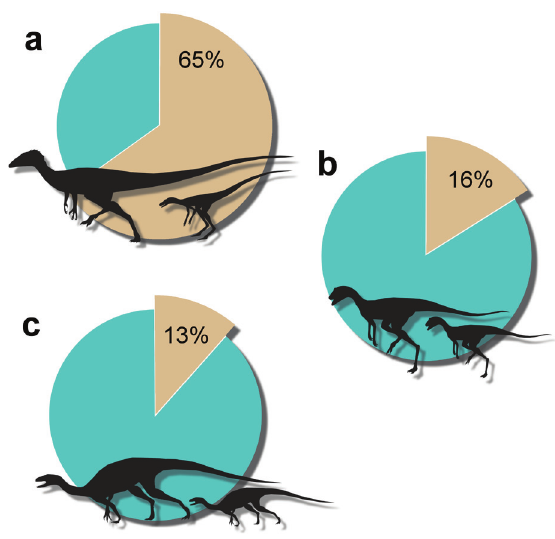
Figure 1 - Percentage of codification differences of femoral characters. a , difference between Dromomeron romeri and Tawa hallae ; b , difference between small and large specimens of Dromomeron gregorii ; c , difference between small and large specimens of Silesaurus opolensis .